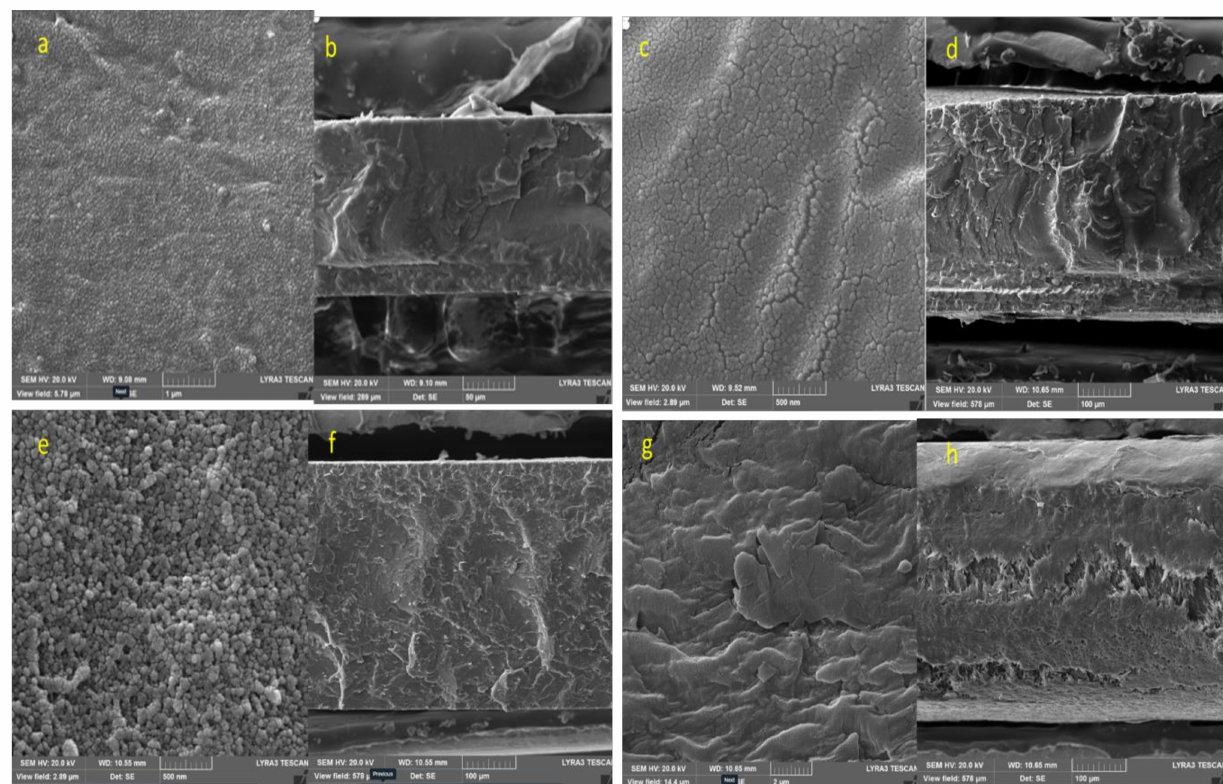
Figure 11. ( a ) PVDF virgin (SDF) (top surface), ( b ) SDF fracture surface, ( c ) SDFG-0.5 (top surface), ( d ) SDFG-0.5 fracture surface, ( e ) SDFG-2 (top surface), ( f ) SDFG-2 fracture surface, ( g ) SDFG-5.0 (top surface), and ( h ) SDFG-5.0 fracture